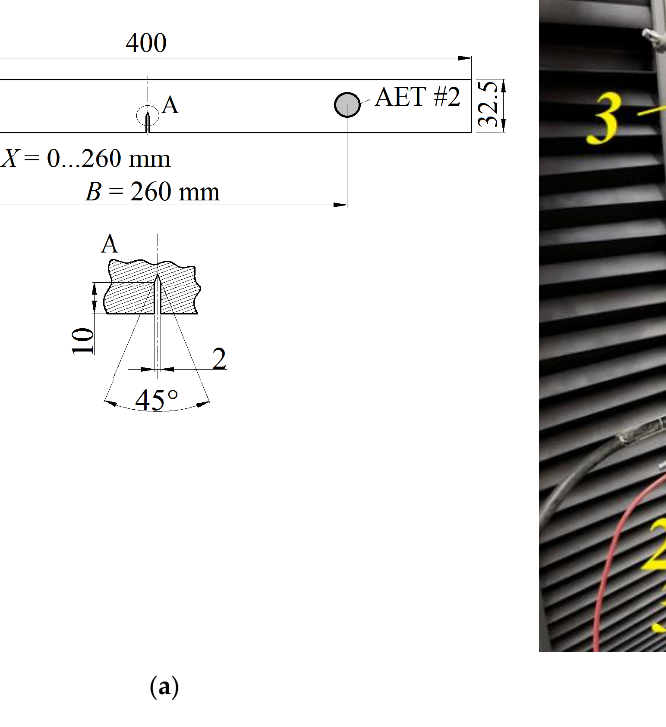
Figure 3. Scheme of a specimen from 30 KhGSA steel with a side notch for testing to assess the scale factor impact on the AE signal parameters ( a ) and photo of experiments using an AE system ( b ): 1—a specimen with a V-shaped notch; 2—quasi-resonant transducers VS150-RIC; 3—clamps. The thickness of the specimens was chosen as a variable dimensional (scale)